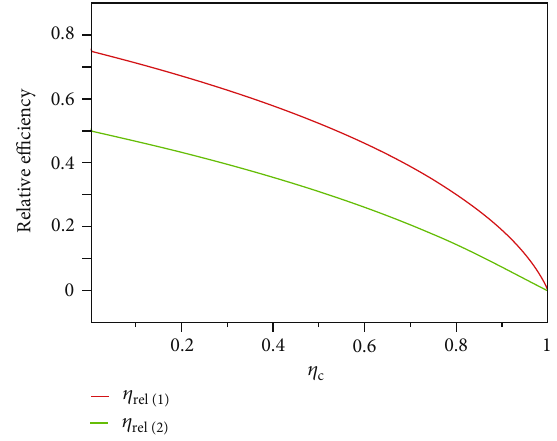
= η − η / η rel opt mp mp ) of the two